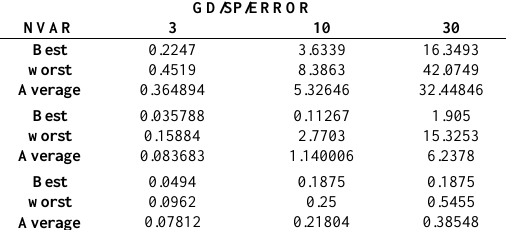
Table 15: Test results for second test function. GD/SP/ERROR NVAR 3 10 30 Best worst